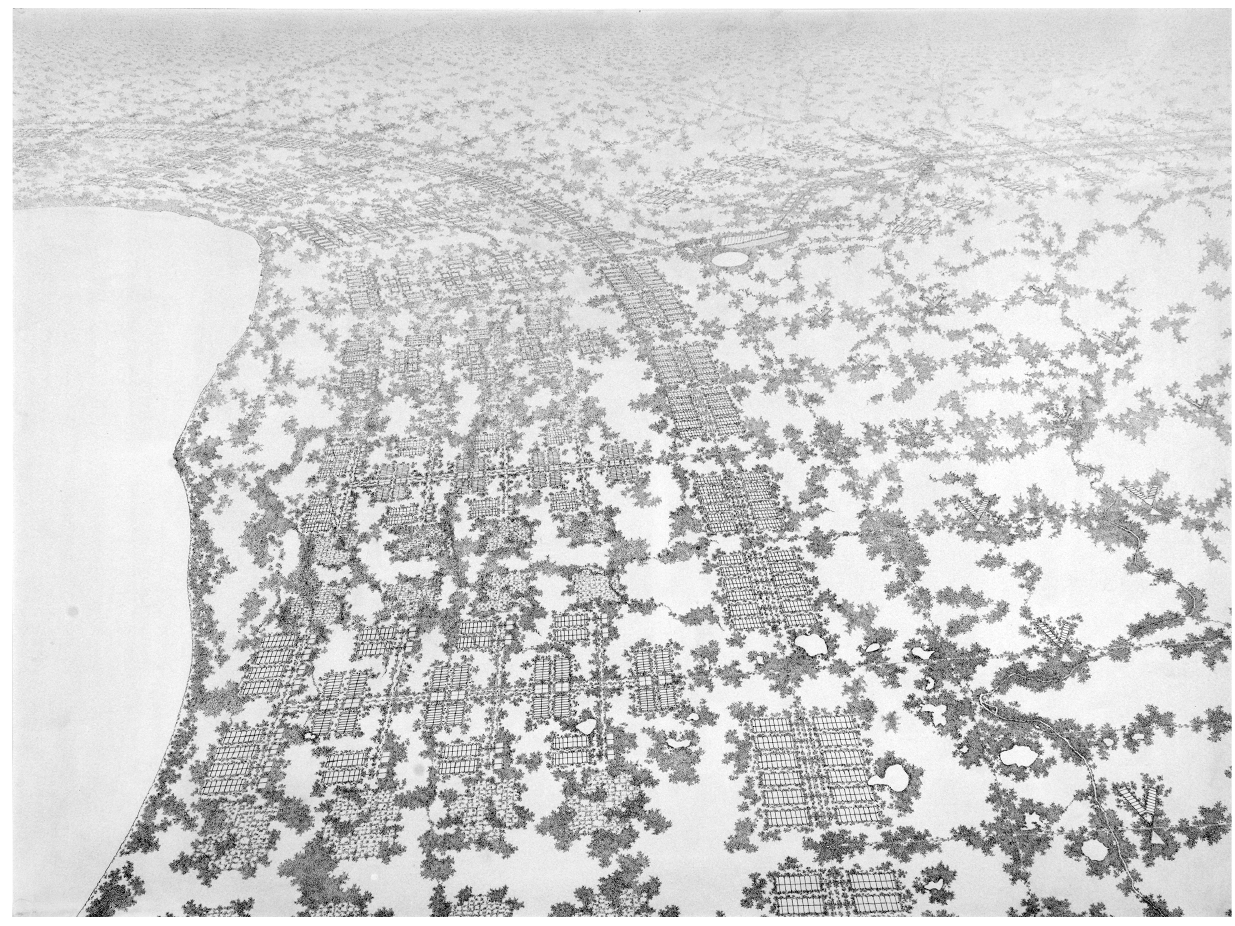
Figure 1. The city in the landscape: Ludwig Hilberseimer, planner, with Alfred Caldwell, delineator, 1942. Courtesy of the Canadian Centre for Architecture, Montreal, Gift of Alfred